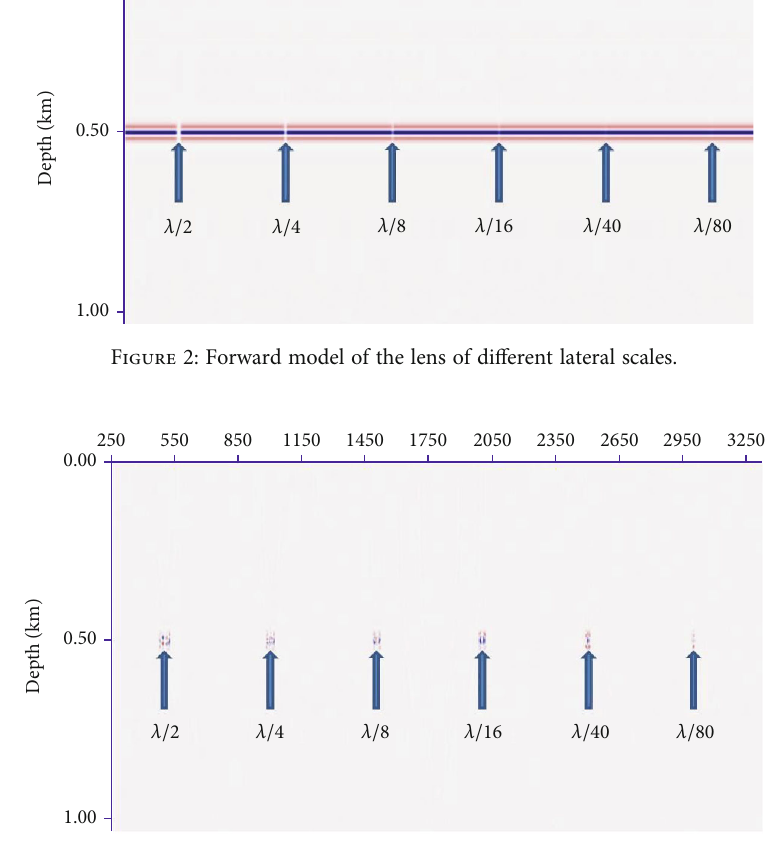
Figure 3: Forward model of the di ff racted wave of di ff erent lateral